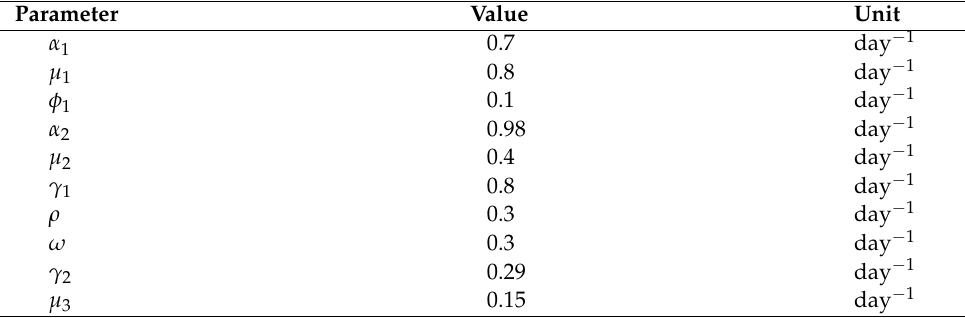
Table 1. The fixed parameters used in zero and Hopf